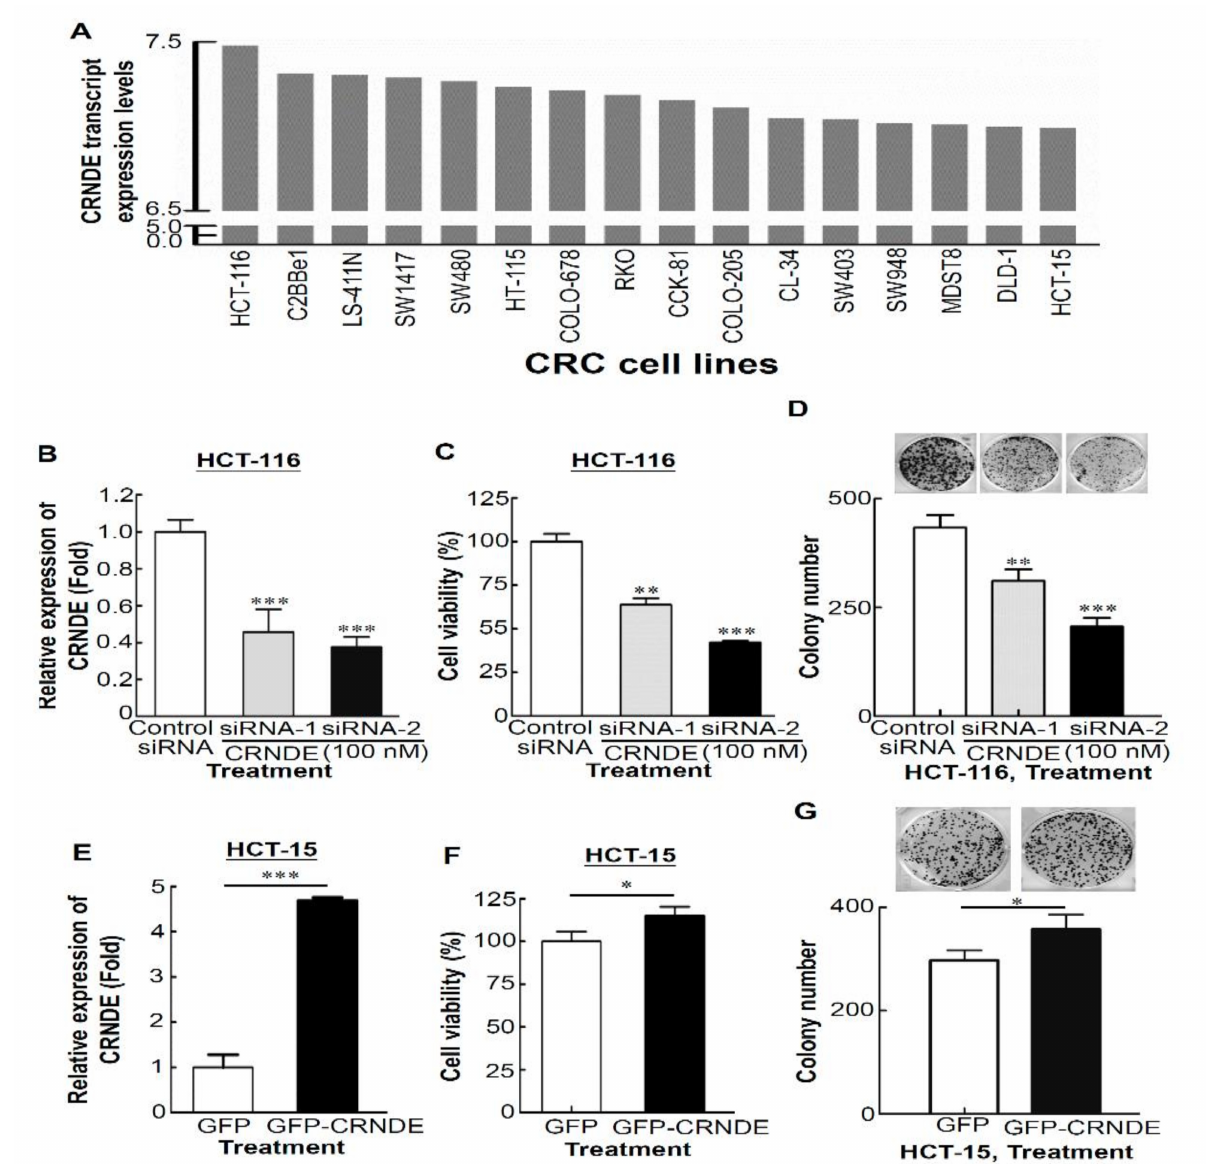
Figure 2. Colorectal neoplasia differentially expressed (CRNDE) regulates the proliferation of colorectal cancer (CRC) cells. ( A ) Expression levels of CRNDE in 16 CRC cell lines were obtained from the CellExpress database. ( B ) CRNDE levels in HCT-116 cells after siRNA-mediated knockdown of CRNDE were detected by an RT-qPCR. ( C ) An MTT assay was performed to determine the proliferation of CRNDE-depleted HCT-116 cells. ( D ) A colony-forming assay was performed to determine the effects of CRNDE depletion on the growth of HCT-116 cells. ( E ) Expression levels of CRNDE in green fluorescent protein (GFP)-CRNDE-transfected HCT-15 cells. The GFP-CRNDE-regulated cell proliferation of HCT-15 cells by an MTT assay analysis ( F ) and colony-forming assay ( G ).* p < 0.05, ** p < 0.01, *** p <